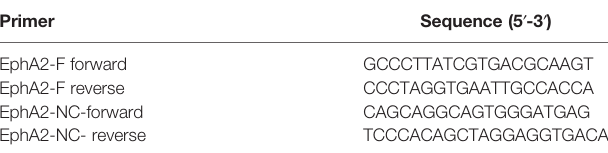
TABLE 3 | Primers used for